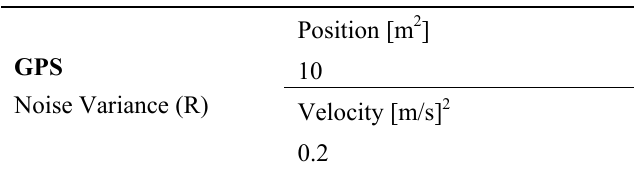
Table 3. Noise covariance features.